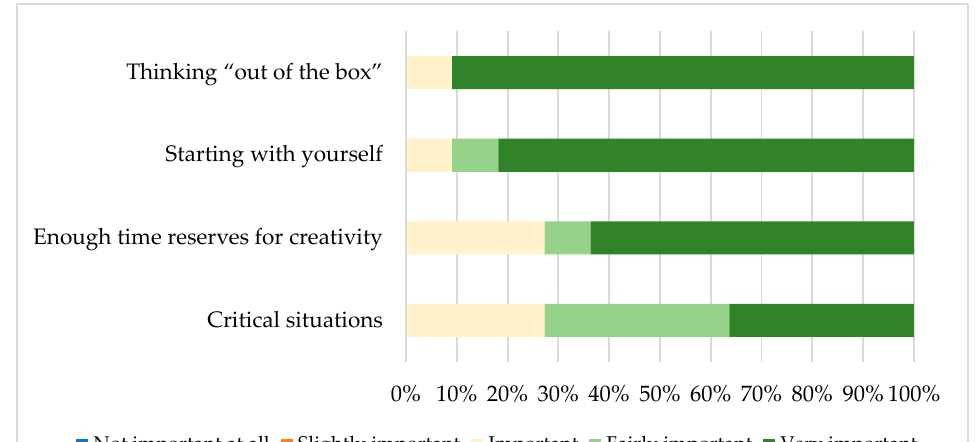
Figure 2. Preconditions for “smart” solutions in rural areas. Source: created by authors, based on research results.